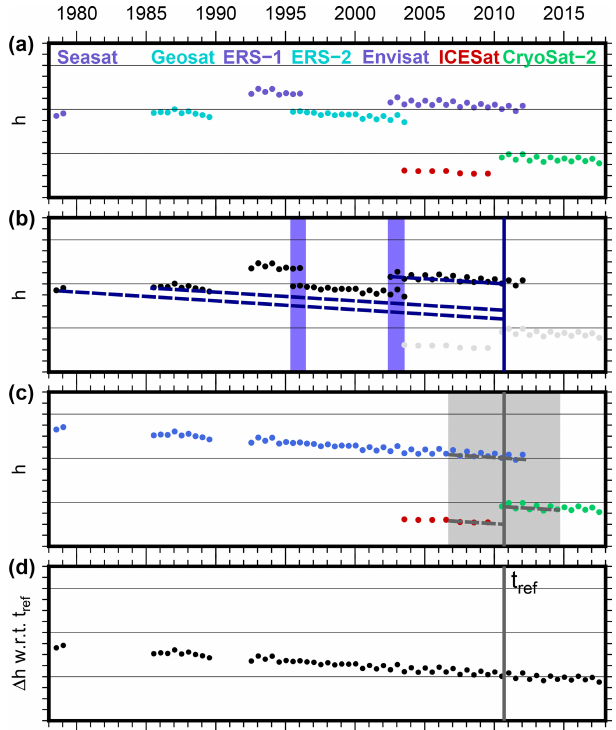
Figure 5. Schematic illustration of the combination of the missions. (a) Single-mission time series of PLRA missions (blue and cyan), CryoSat-2 in SARIn mode (green) and the laser altimetry measure- ments of ICESat (red) with inter-mission offsets. (b) Offsets be- tween the PLRA data are determined from overlapping epochs (blue area) or trend-corrected elevation differences (according to Eq. 2) where d h/ d t is sufficiently stable. (c) The specific offset between PLRA, SARIn and laser data depends on the sampling of the topog- raphy within each single cell. These different techniques are aligned by reducing each elevation time series by the specific elevation at the reference epoch t ref . Due to possible nonlinear surface elevation changes, this reference elevation is obtained from an 8-year inter- val only (gray area). (d) The combined multi-mission time series contains SECs with respect to t ref